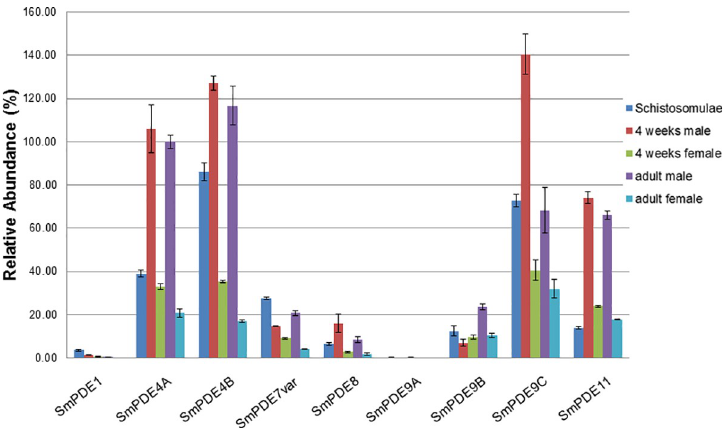
Fig 2. Expression levels of SmPDEs from the S . mansoni developmental stages that exist in mammalian hosts. Expression of the cloned and sequence-confirmed SmPDEs in cDNA from schistosomula, male and female juvenile worms, and male and female adult worms was determined by qRT-PCR and normalised to the level of expression of the housekeeping gene COX1; the expression level of Sm4A in male adult worms was arbitrarily set as 100% and the entire dataset (all life-cycle stages) expressed as a percentage thereof. cDNA was produced multiple times from Cairo strain S . mansoni RNA samples; each bar represents the mean and SEM of 4–12 qPCR